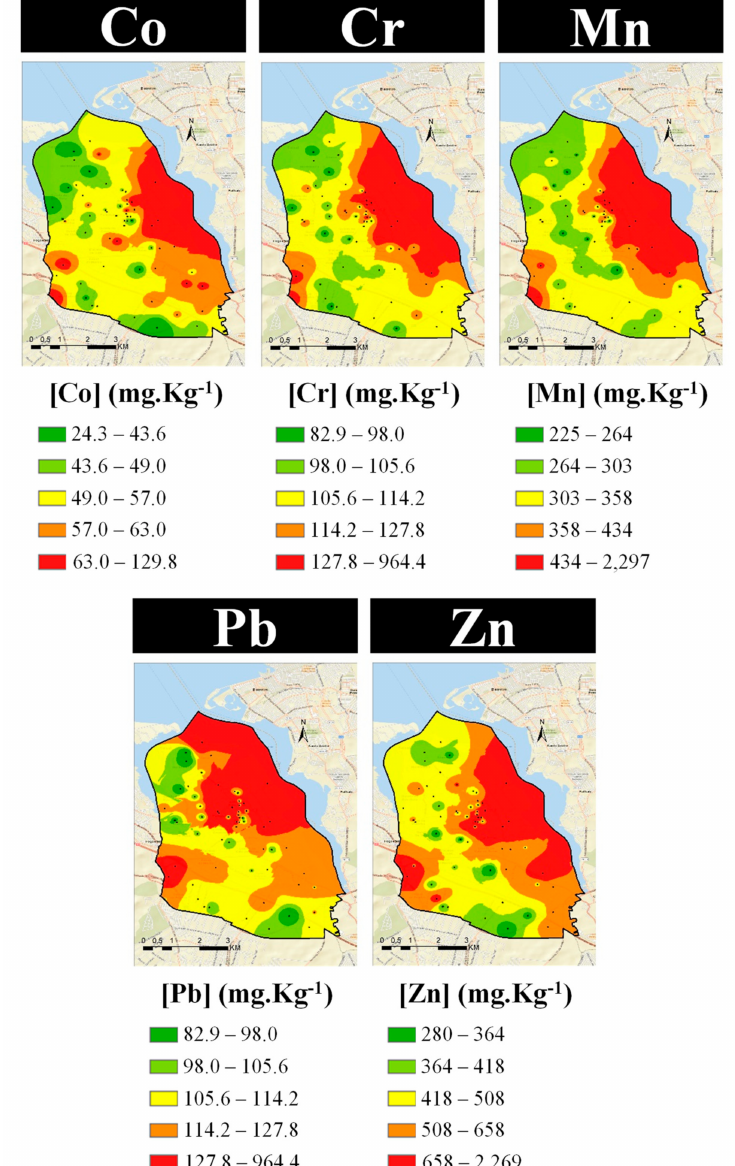
Figure 11. Spatial distribution of elements related with anthropogenic origin, namely industry. The spatial distribution of the elements discussed previously is in accordance with the Air Quality Map of Seixal, according to which the highest values of particulate matter (PM 10 and PM 2.5 ) were registered in the industrial areas and main roads of the munici- pality [67]. The authors concluded that the air quality index regarding PM 10 is “average” generically throughout the municipality, except in the industrial area where it is “weak” or “bad”; for PM 2.5 , the air quality index varies from generically “weak” to “very bad” in the industrial